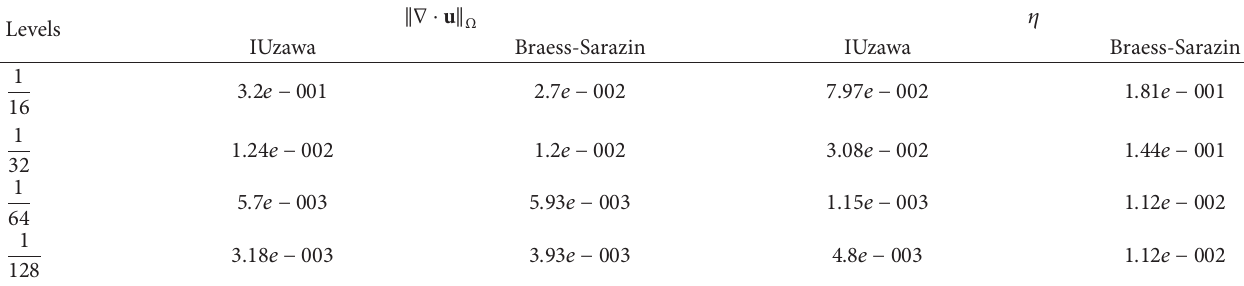
Table 8: Changes in the ‖∇ ⋅ u ‖ Ω estimated velocity divergence error using multigrid 𝑉 -cycle. 𝜂: the global error estimator using different smoothers from one level to the